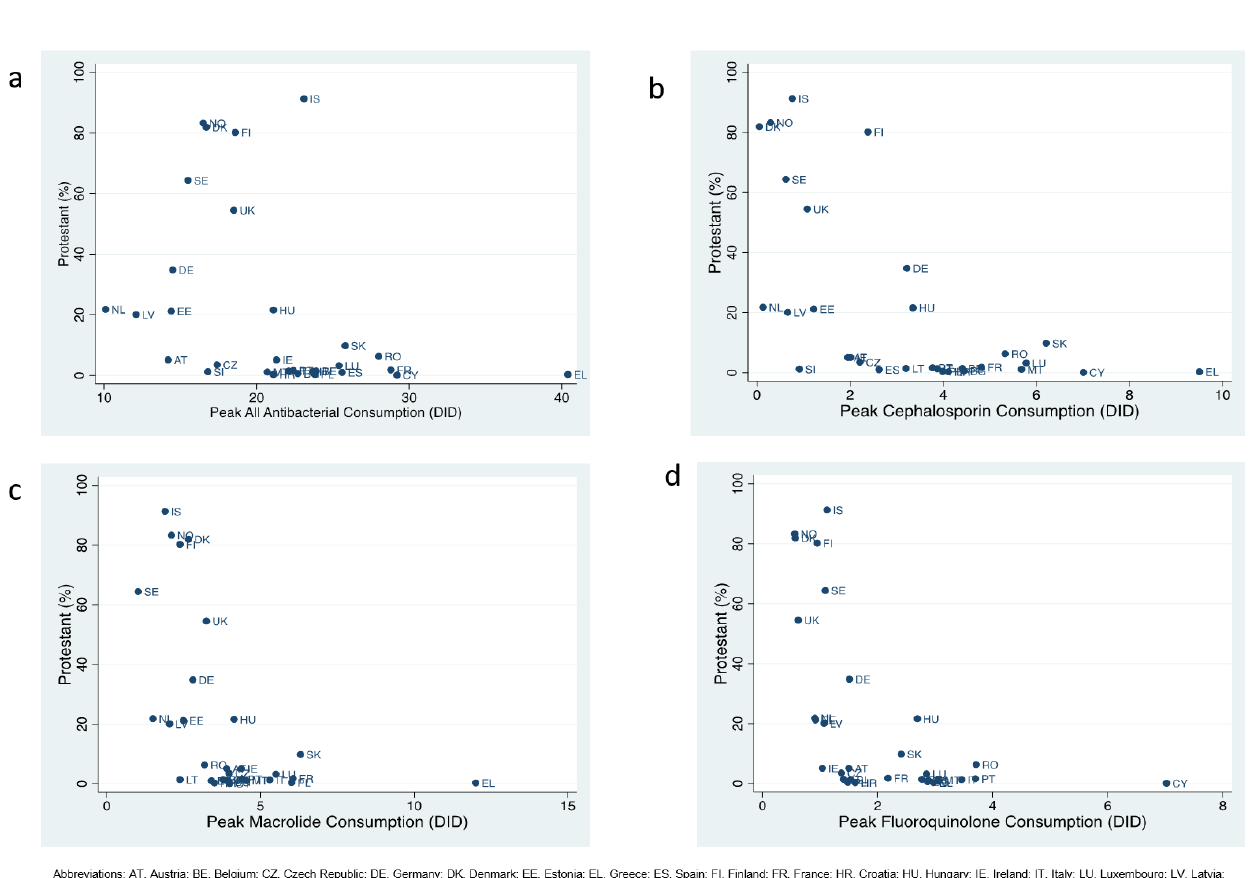
Figure 1. Scatter diagrams of percent of a country that is Protestant and consumption (defined daily doses/ 1000 individuals/ day – DID) of all antibacterials ( a ), cephalosporins ( b ), macrolides ( c ) and fluoroquinolones ( d ) in 30 European countries.